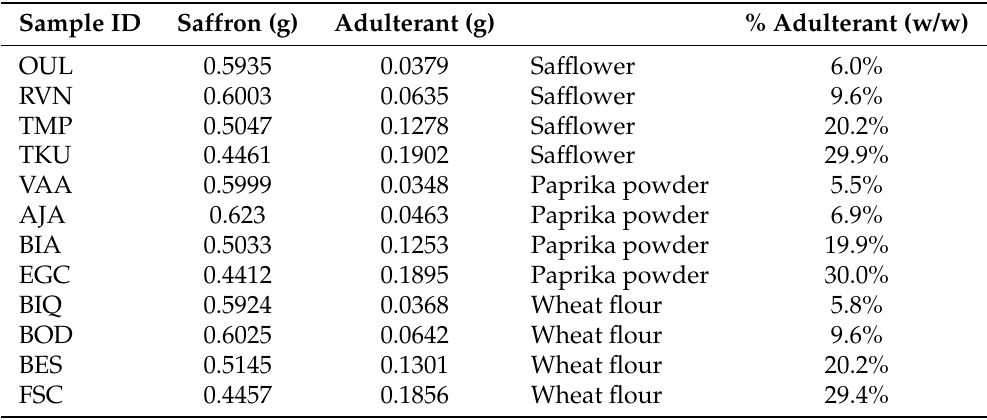
Table A2. Overview of in-house produced admixtures for method validation. Each mixture was milled and extracted using the same procedures as for the other samples.